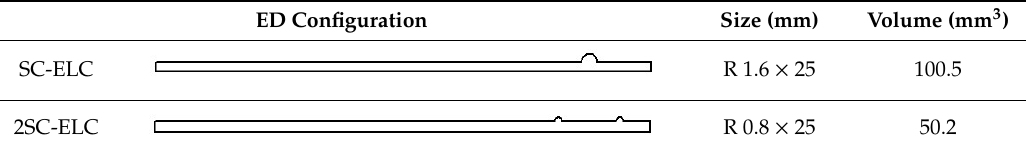
Figure 3. Mold design of Energy director (ED) composite laminate manufacturing. Table 2. Energy Director Configurations.